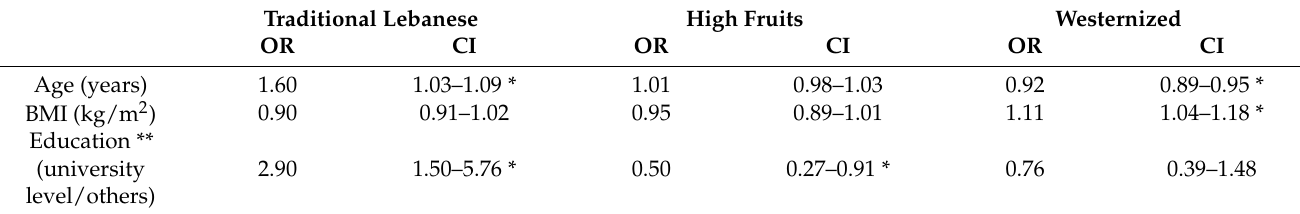
Table 3. Association between dietary patterns, sociodemographic and clinical characteristics in the study